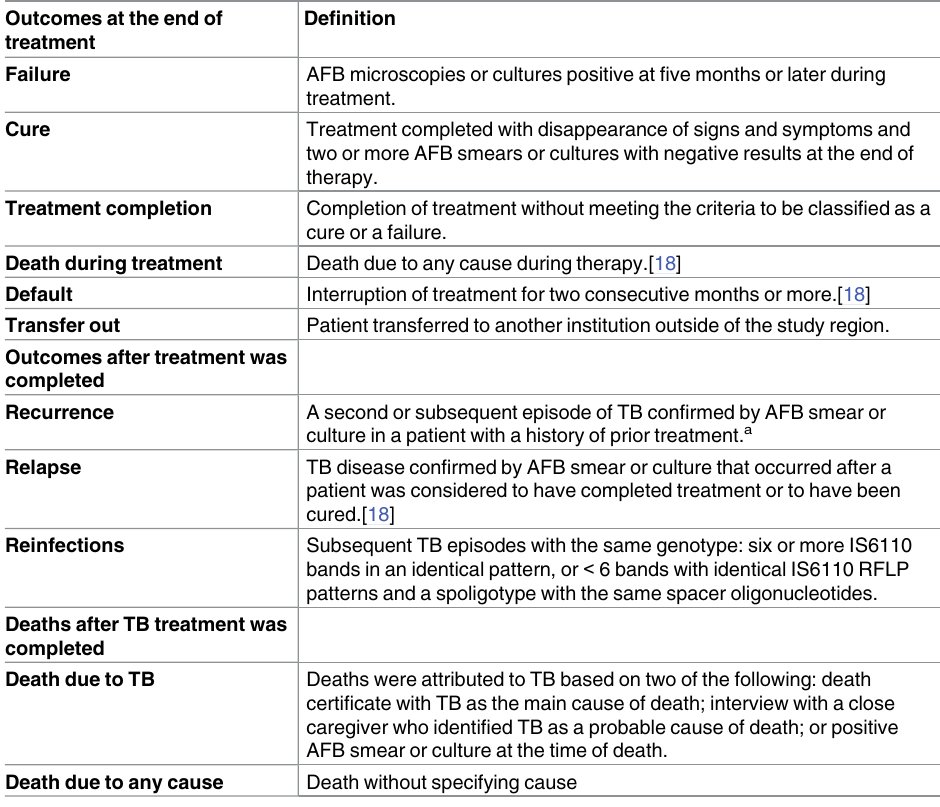
Table 1. Definition of Treatment